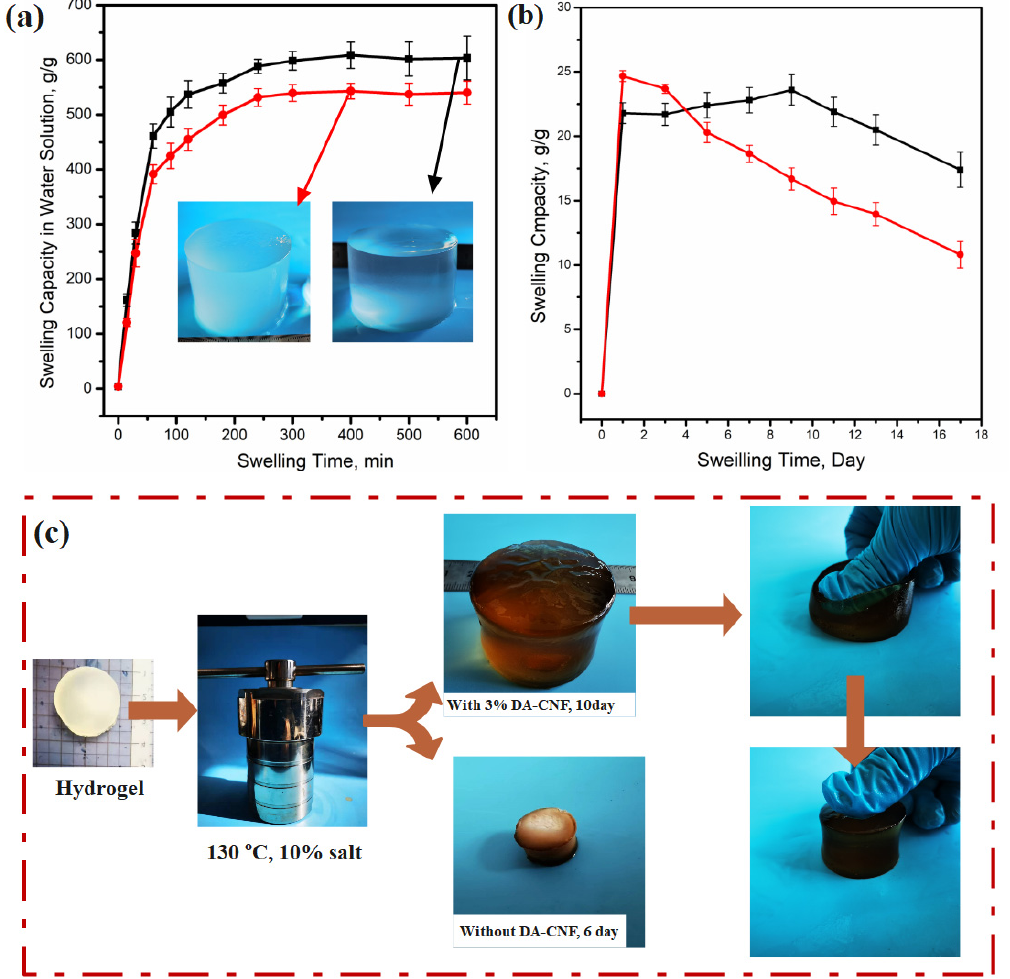
Figure 6. The swelling kinetics for all hydrogels in high-temperature and salt environment. ( a ) The equilibrium swelling ratio of all hydrogels in deionized water. ( b ) The equilibrium swelling ratio of all hydrogels in 10% salt solution. ( c ) Image shows the hydrogel aging in the salt solution.